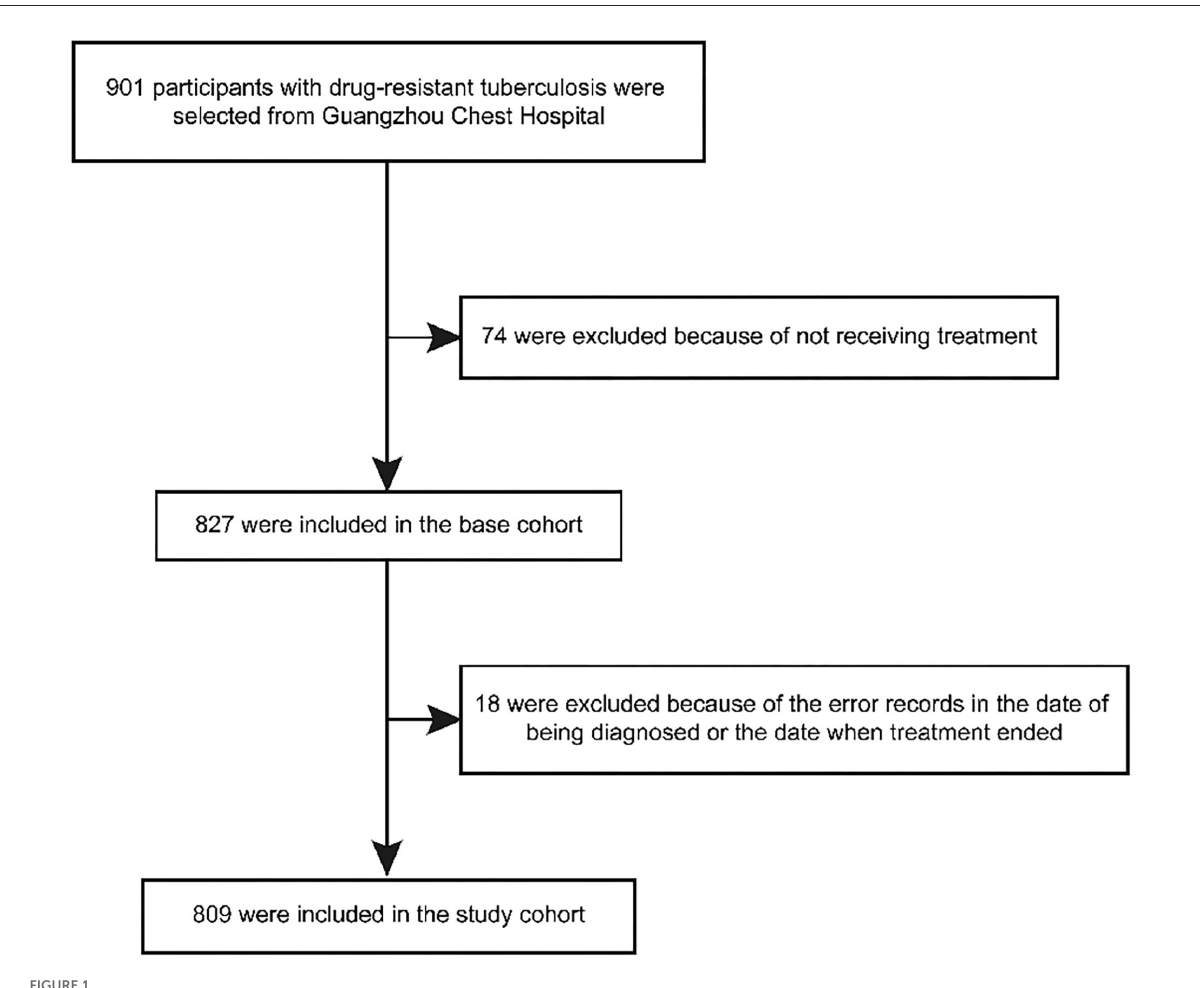
FIGURE1 Flowchart of the study